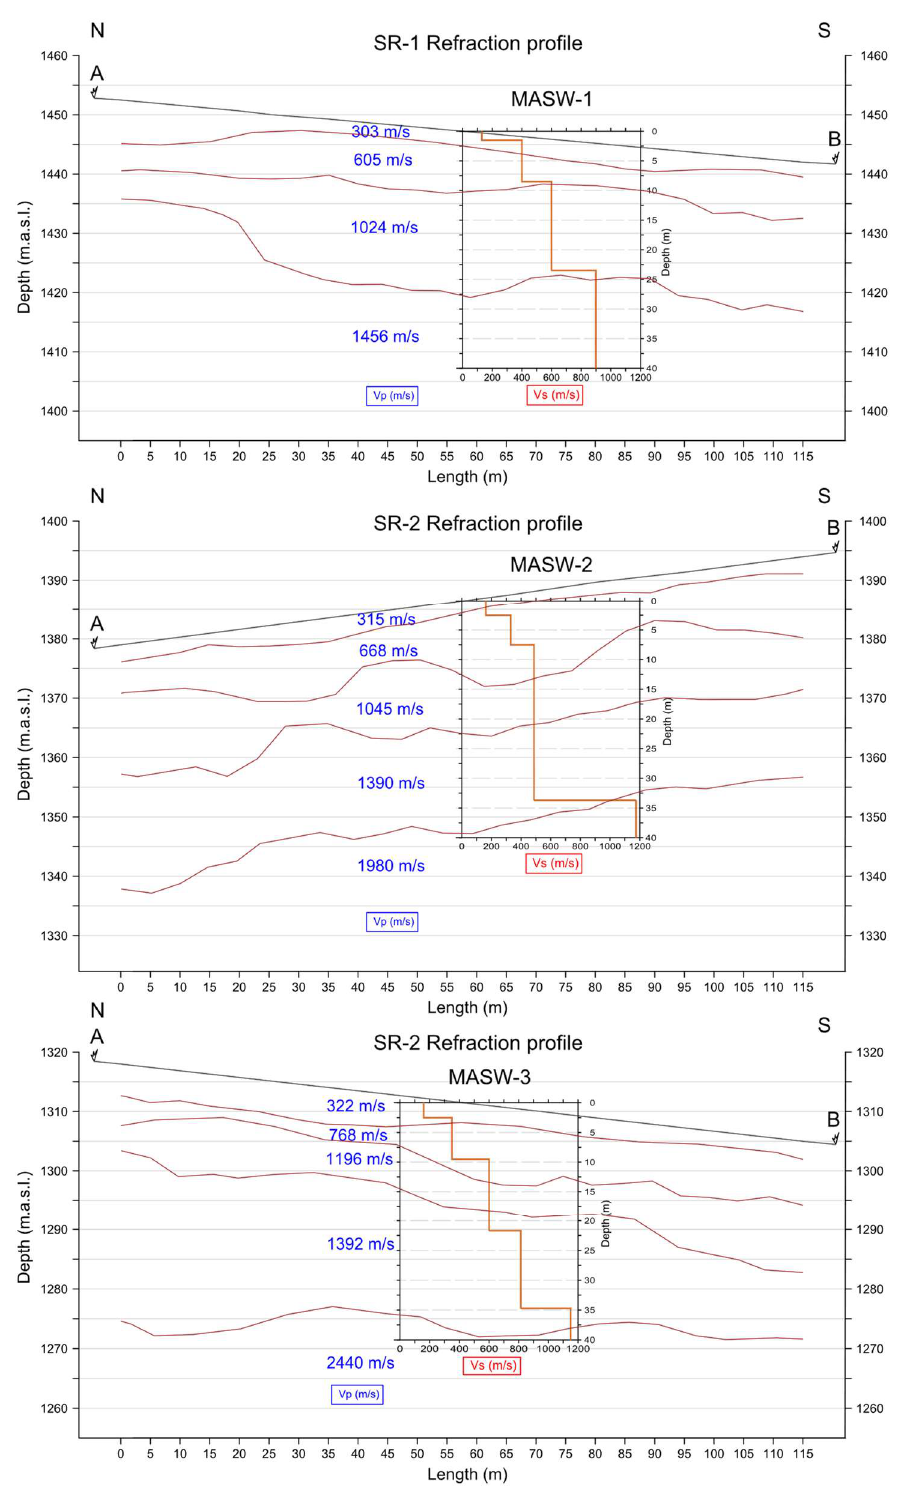
Figure 5. Two-dimensional refraction seismic interpretation profiles with V p values (in blue) and overlayed MASW profiles results ( V s in red squared lines, 1D solution). Both profiles were made at the exact location.